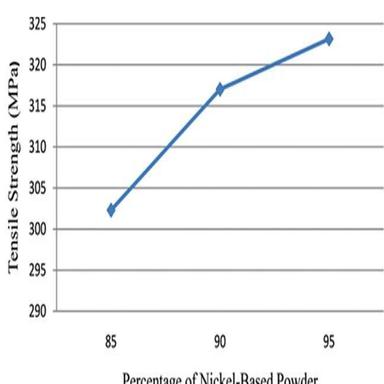
Tensile strength vs. percentage of nickel-based powder .